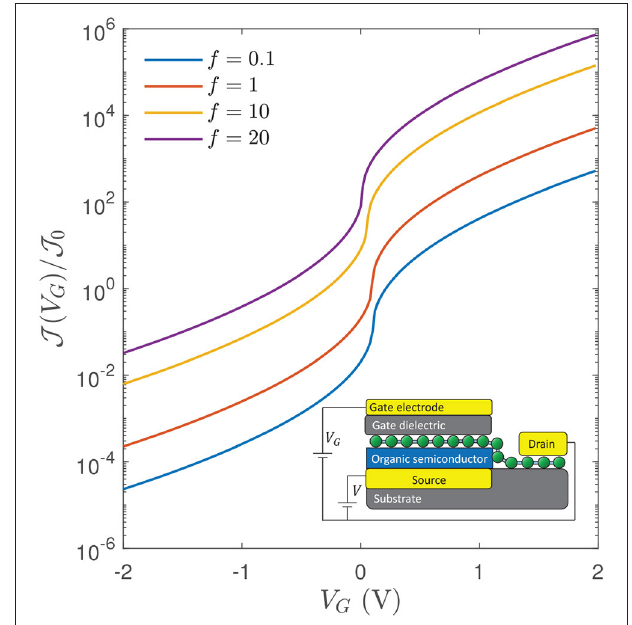
FIGURE 3 | Transfer characteristics of a top-gated graphene/organic field-effect Schottky barrier transistor at various bias voltage parameter, f . Inset shows the schematic drawing of the device. The injection current is calculated by considering a gate dielectric thickness of d G 5 nm and of dielectric = constant ε G 6.4 which is typical for Al 2 O 3 gate dielectric. The organic = semiconductor dielectric constant is assumed to be ε 3.5 and the device is = operated at room temperature T 300 =